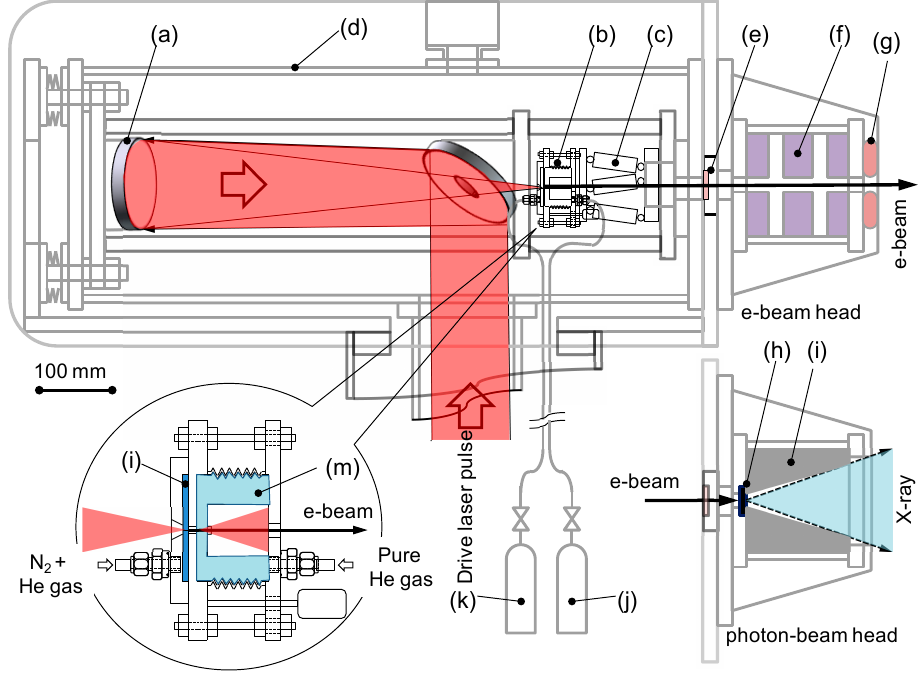
Figure 6. A schematic of the gantry head, comprising ( a ) a final focus mirror; ( b ) two-stage gas cell; ( c ) multi-axis positioning stage for the gas cell, e.g., miniature 6-axes hexapod; ( d ) vacuum chamber containing the laser plasma accelerator and drive laser optics; ( e ) vacuum window thin film, e.g., beryllium, for separating vacuum and air; ( f ) beam focusing system assembled three permanent quadrupole magnets; ( g ) current transformer for measuring electron beam charge; ( h ) Bremsstrahlung conversion target; ( i ) photon beam collimator; ( j ) pure He gas fed to the accelerator; ( k ) N 2 and He mixed gas fed to the injector; ( l ) injector gas cell; and ( m ) accelerator gas